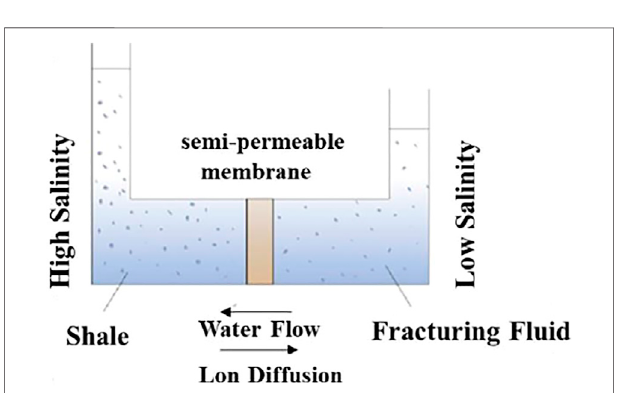
FIGURE 14 | Diagram of the osmosis